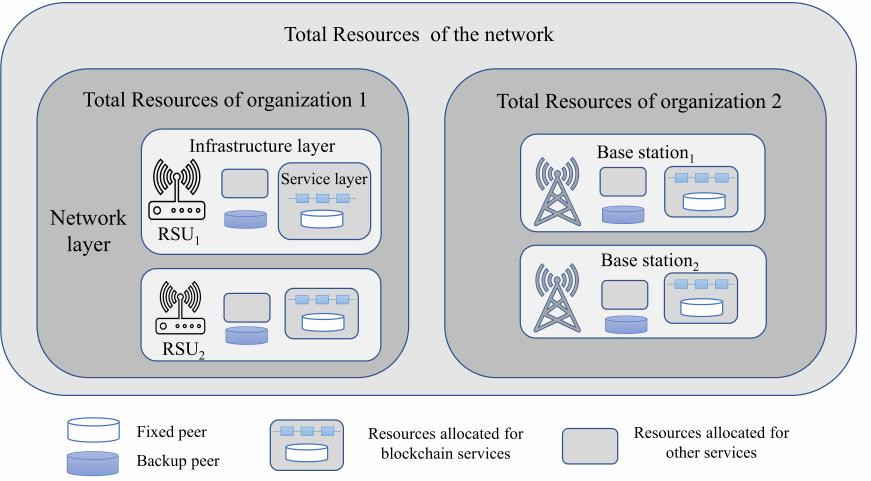
Figure 2. Resources distribution and layering of the